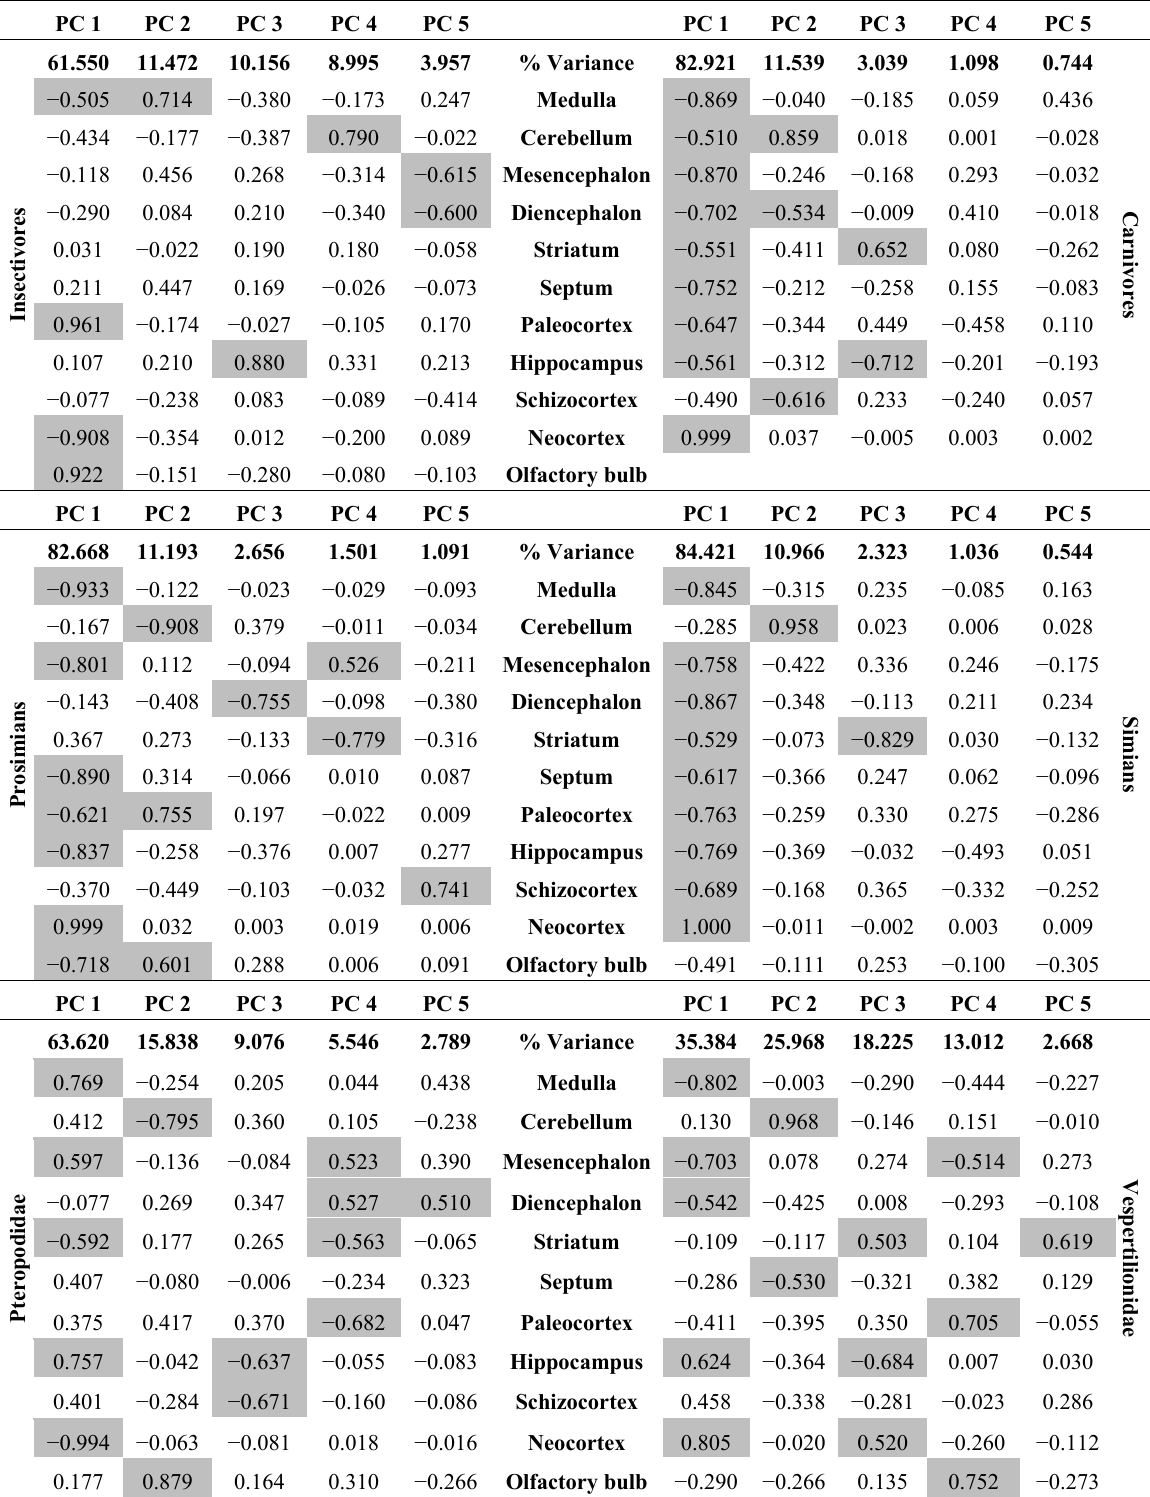
Table 2. Loadings of the brain structures for the five first principal components of PPCA for each taxon of the Figures 2 to 7. Scores higher than 0.5 are highlighted in